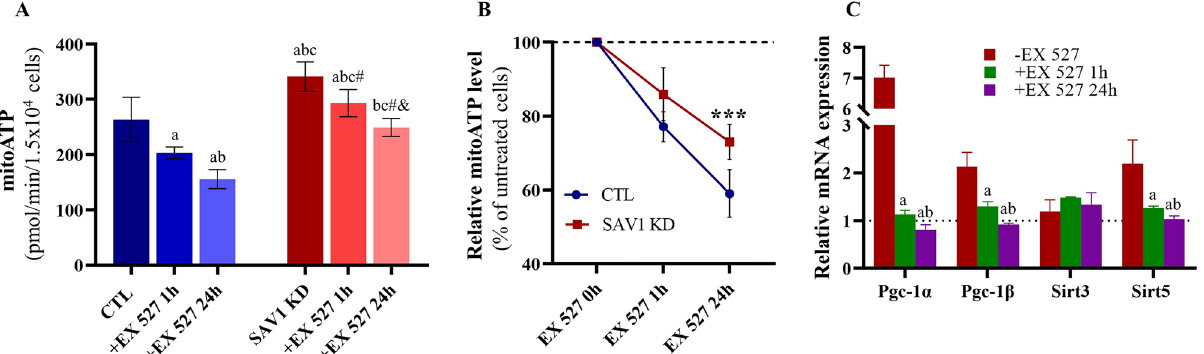
Figure 6. Effects of sirtuin 1 (Sirt1) inhibition on mitochondrial ATP production. ( A ) Representative analysis of mitochondrial ATP generation of SAV1 KD and CTL cells in the absence and presence of the Sirt1 inhibitor EX 527 for 1 h and 24 h under basal conditions. One-way ANOVA with Tukey’s multiple comparisons test; p ≤ 0.05 is statistically significant. Data are mean ± SD, n = 3 independent measurements. a = significant vs CTL without EX 527; b = significant vs CTL + EX 527 1 h; c = significant vs CTL + EX 527 24 h; # = significant vs SAV1KD without EX 527; and & = significant vs SAV1 KD + EX 527 1 h. ( B ) SAV1 KD cells are more resistant to EX 527-induced reduction of mitochondrial ATP production. Unpaired t test for comparison between SAV1 KD and CTL cells within the same time period. ***p < 0.001. ( C ) Sirt1 inhibition induced a time- dependent suppression of mRNA levels of Pgc-1α , Pgc-1β , and mitochondrial Sirt5 . One-way ANOVA with Tukey’s multiple comparisons test; p ≤ 0.05 is statistically significant. Data are mean ± SD, n = 3 independent measurements. a = significance vs. SAV1 KD cells in the absence of EX 527 within the same gene; b = significance vs. SAV1 KD cells treated with EX 527 1 h within the same